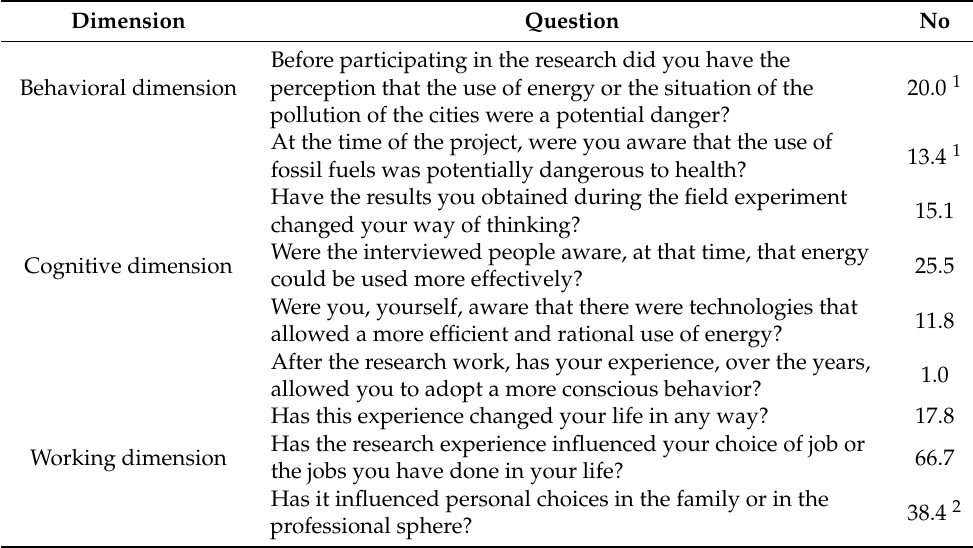
Table 1. Former adolescents participating in 1980s projects interviewed today. These data are ret- rospective analysis of high school students’ attitudes and understanding about their involvement in collecting data regarding energy use and air quality during the 1980s in Turin and Rome, Italy. The numbers refer to today’s perception of the past participatory experience of former adolescents determined through questions that refer to the behavioral, cognitive and working spheres. Question- naires completed in February 2021 by a sample of CS projects’ former participants. Individuals who completed surveys (N = 34) were more likely to be female (55%), age 55 ± 4, education level (78% post-secondary), STEM education level (74% post-secondary). Answers as a